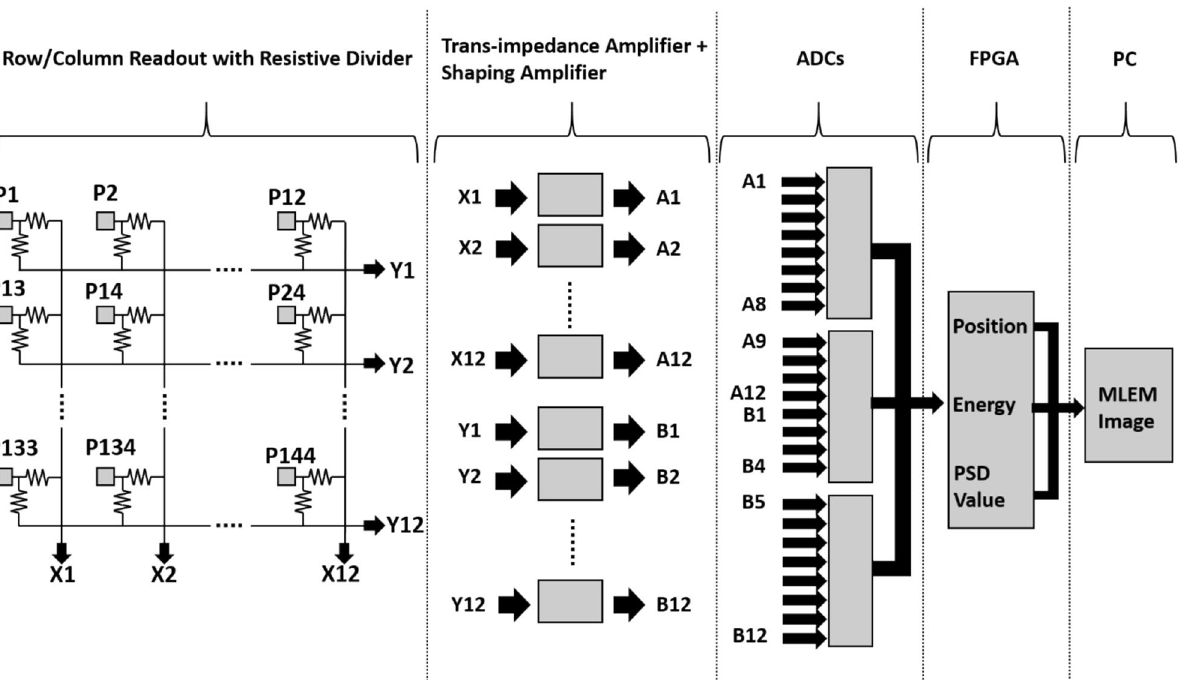
Figure 13. Hardware configuration with row/column summing readout and 3 ADCs for 144 pixels upon the SiPM array coupled to stilbene scintillator array implemented on coded-aperture hand-held imaging